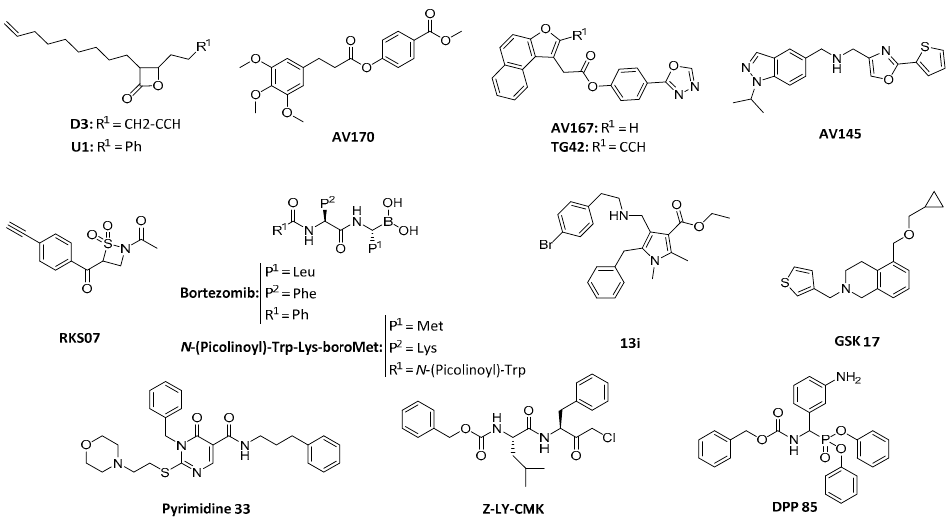
Figure 7. Chemical structure of reported ClpP inhibitors.